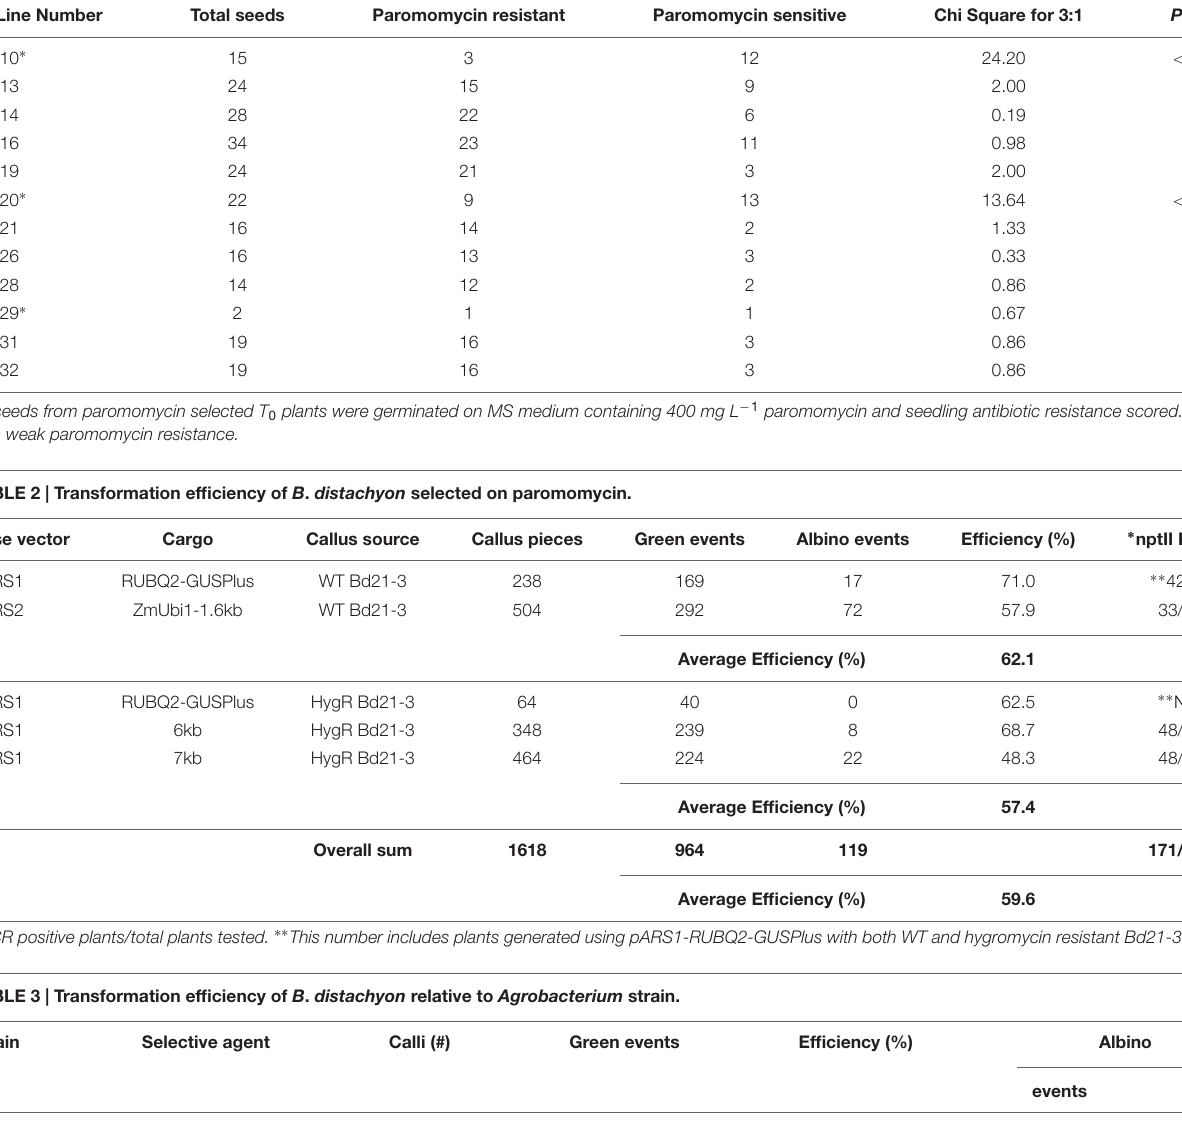
TABLE 1 | Segregation analysis of PCR confirmed paromomycin selected transgenic B . distachyon T 1 families. T0 Line Number Total seeds Paromomycin resistant Paromomycin sensitive Chi Square for 3:1